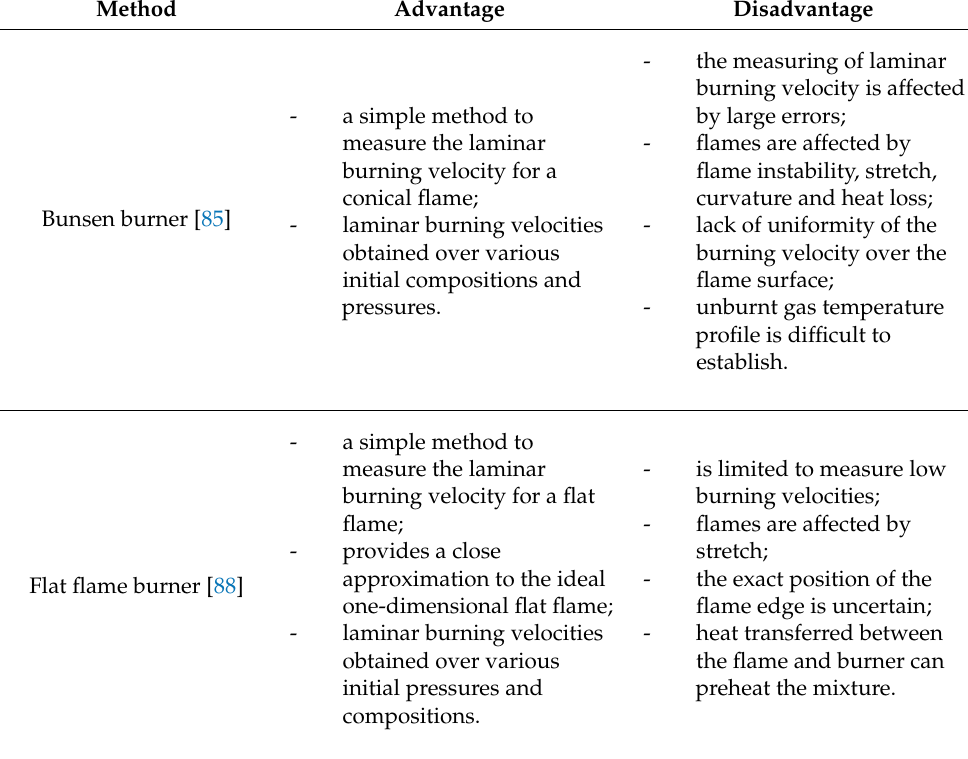
Table 2. Comparison of experimental methods for determining the laminar burning velocity de- scribed in the present